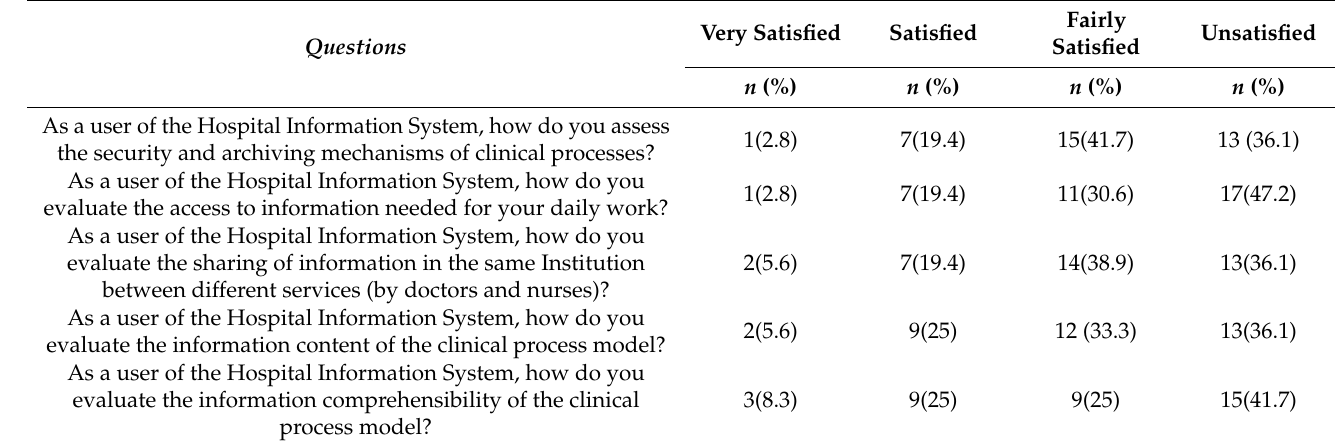
Table 5. Assessment of participants’ satisfaction with hospital information systems ( n =